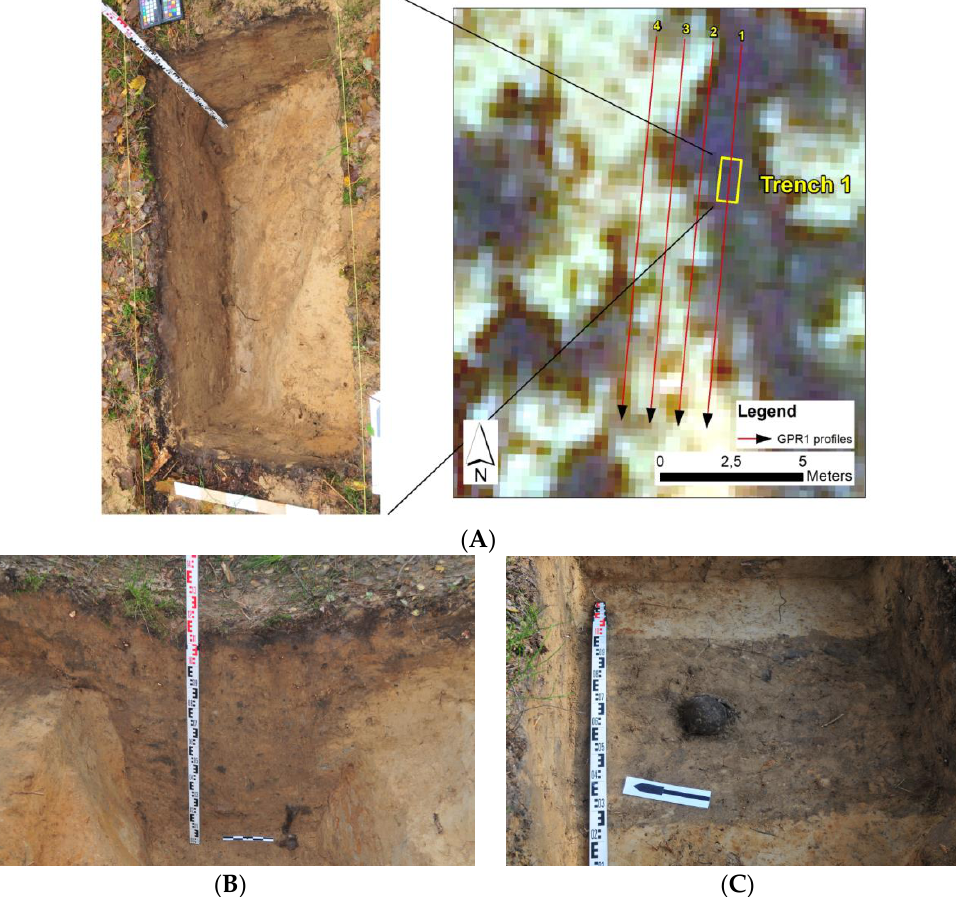
Figure 12. Photos of stratigraphic surveys: ( A ) left: no. 1 trench excavation; photo: R. Zapłata; right: GPR1 profiles superimposed on trench 1 area and orthophotomap from 2017 (© Head Office of Geodesy and Cartography in Poland). ( B ) no. 2 trench excavation; photo: S. Różycki; ( C ) no. 3 trench excavation; photo: S. Różycki.